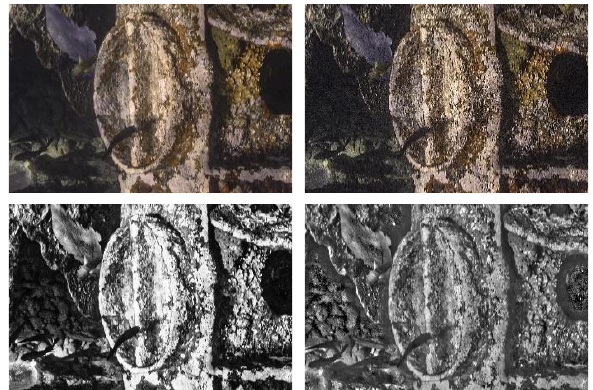
Figure 8. A portion of the right image (representing the mast step) of the stereo couple represented in figure 7 showing the effect of the applied algorithms on the original images; ImageFilter DETAIL (top left), ImageFilter EDGE ENHANCE (top right), SFS (bottom left) and Wallis (bottom right). The effectiveness of the different adopted filters have been tested using the software FME 17 (Feature Matching Evaluation), an open-source tool for the evaluation of different feature detector, descriptor and matching algorithms (González-Aguilera et al., 2016) (Figure 9).